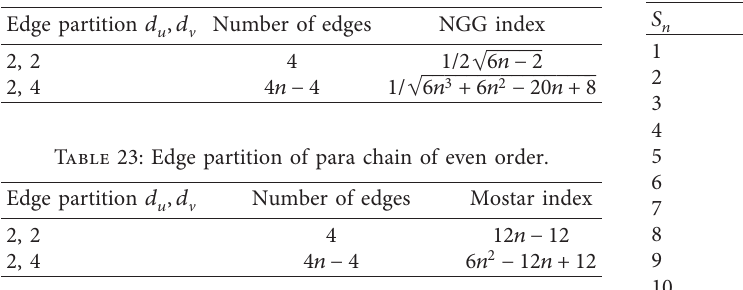
Table 27: Comparison table for ortho chain.